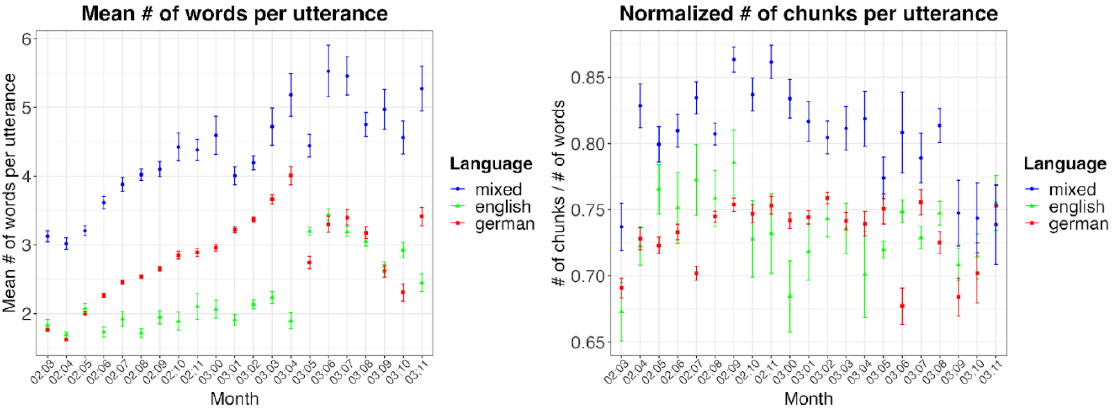
Figure 5. Mean number of words per utterance (left) and the normalized number of chunks per utterance.